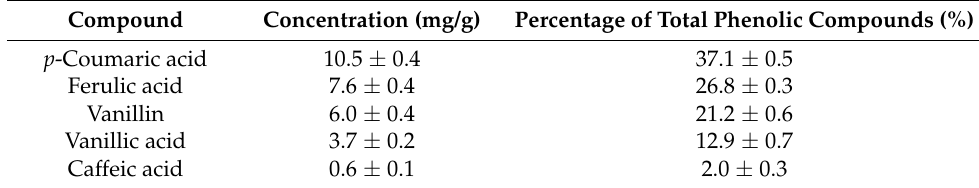
Table 3. Profile of phenolic compounds in propolis raw material.